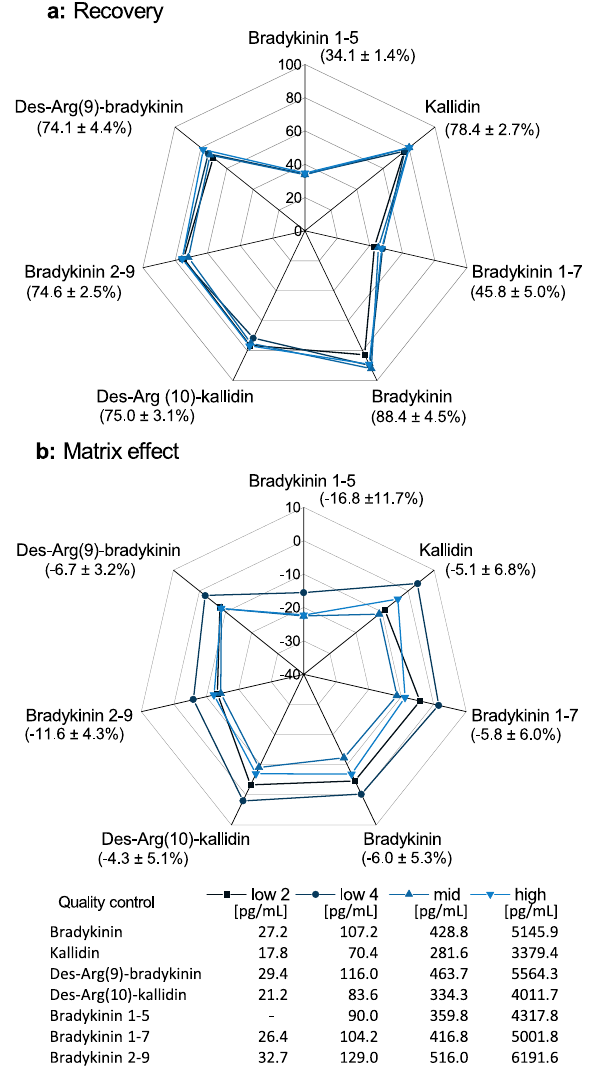
Figure 5. Recovery ( a ) and absolute matrix effect ( b ) of all analytes at the four investigated levels using saline matrix. Mean values and their coefficients of variation are presented in round brackets. Nominal concentrations of the quality control levels are depicted in the amended